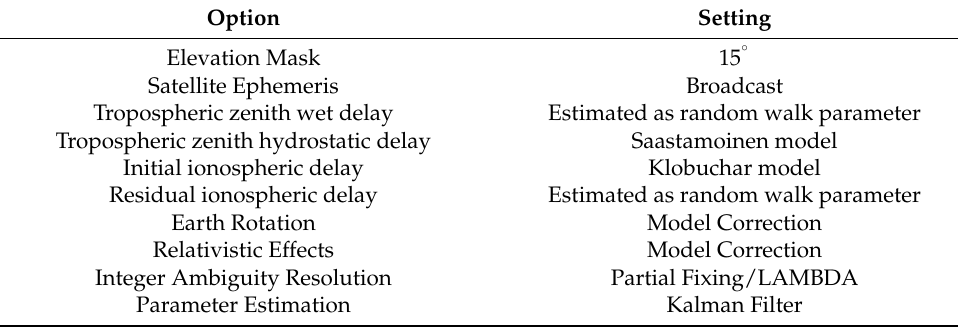
Table 3. Date processing